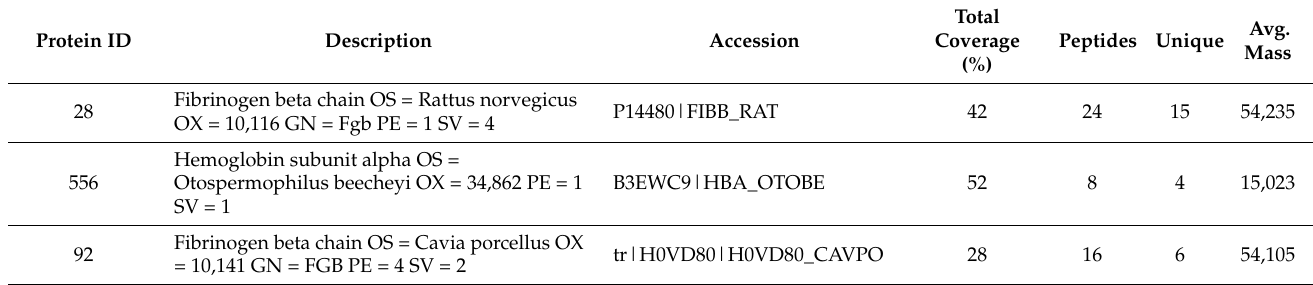
Table 2. The results of LC-MS analysis using the software PEAKS Studio 10.0. Here are listed the most abundant proteins with the highest coverage present in all replicates of AuNP plasma samples (AuNPs with 10%, 25% and 55% plasma). As mentioned earlier, the results obtained were compared against the UniProt mammalian protein